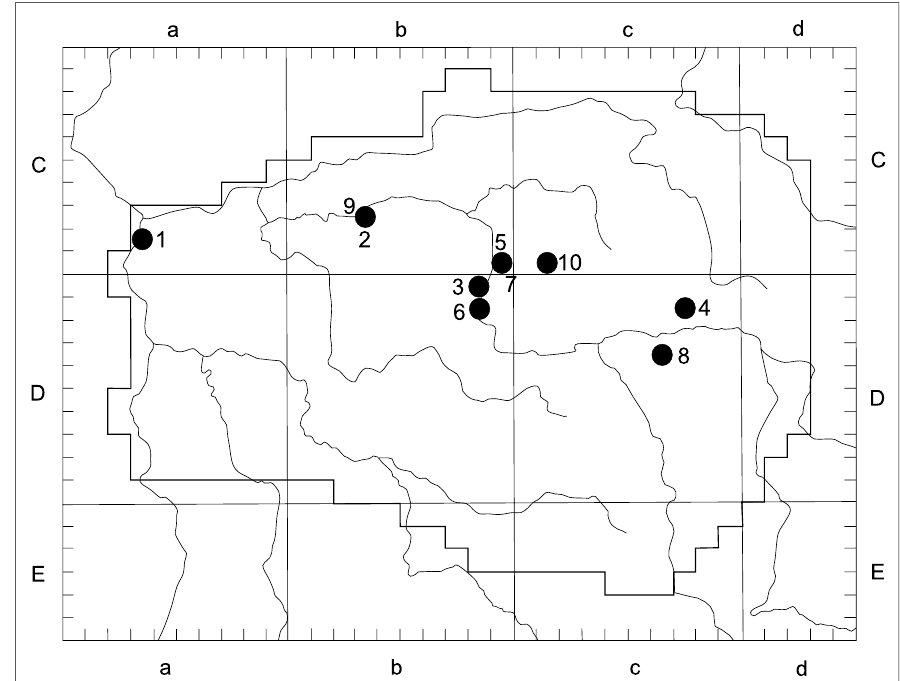
Fig. 1. distribution of localities considered in the article (acc. to Żukowski et al.